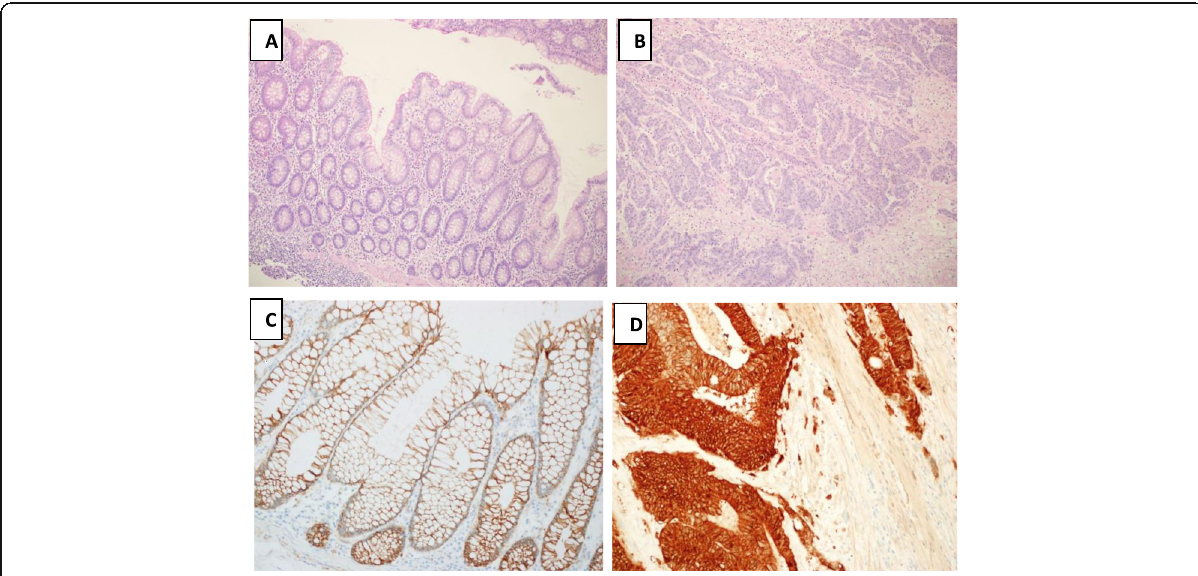
Fig. 3 Protein expression of β -catenin in normal colon and colorectal cancer tissue from the same patient. Normal colon ( a ) and colorectal cancer tissue ( b ) stained with H & E. Slide showing strong nuclear and cytoplasmic localization of β -catenin in the tumor cells ( d ) and weak staining in normal tissue ( c